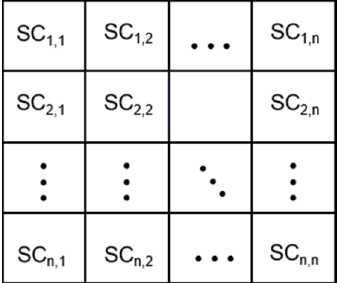
Figure 4. Node consensus trust evaluation.